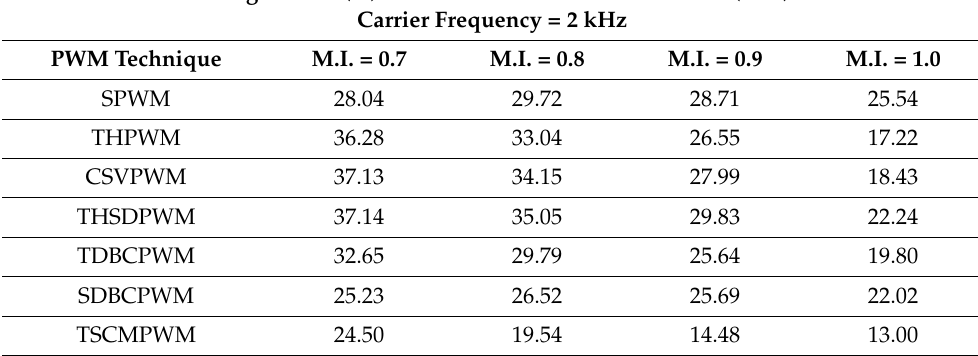
Table 4. Line voltage THDs of different PWM techniques for modulation index variation.